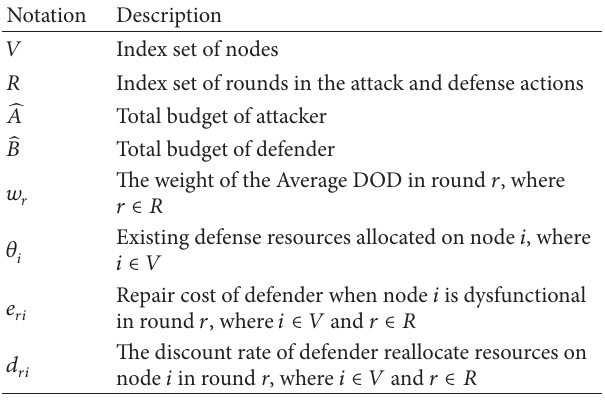
Table 4: Given parameter.